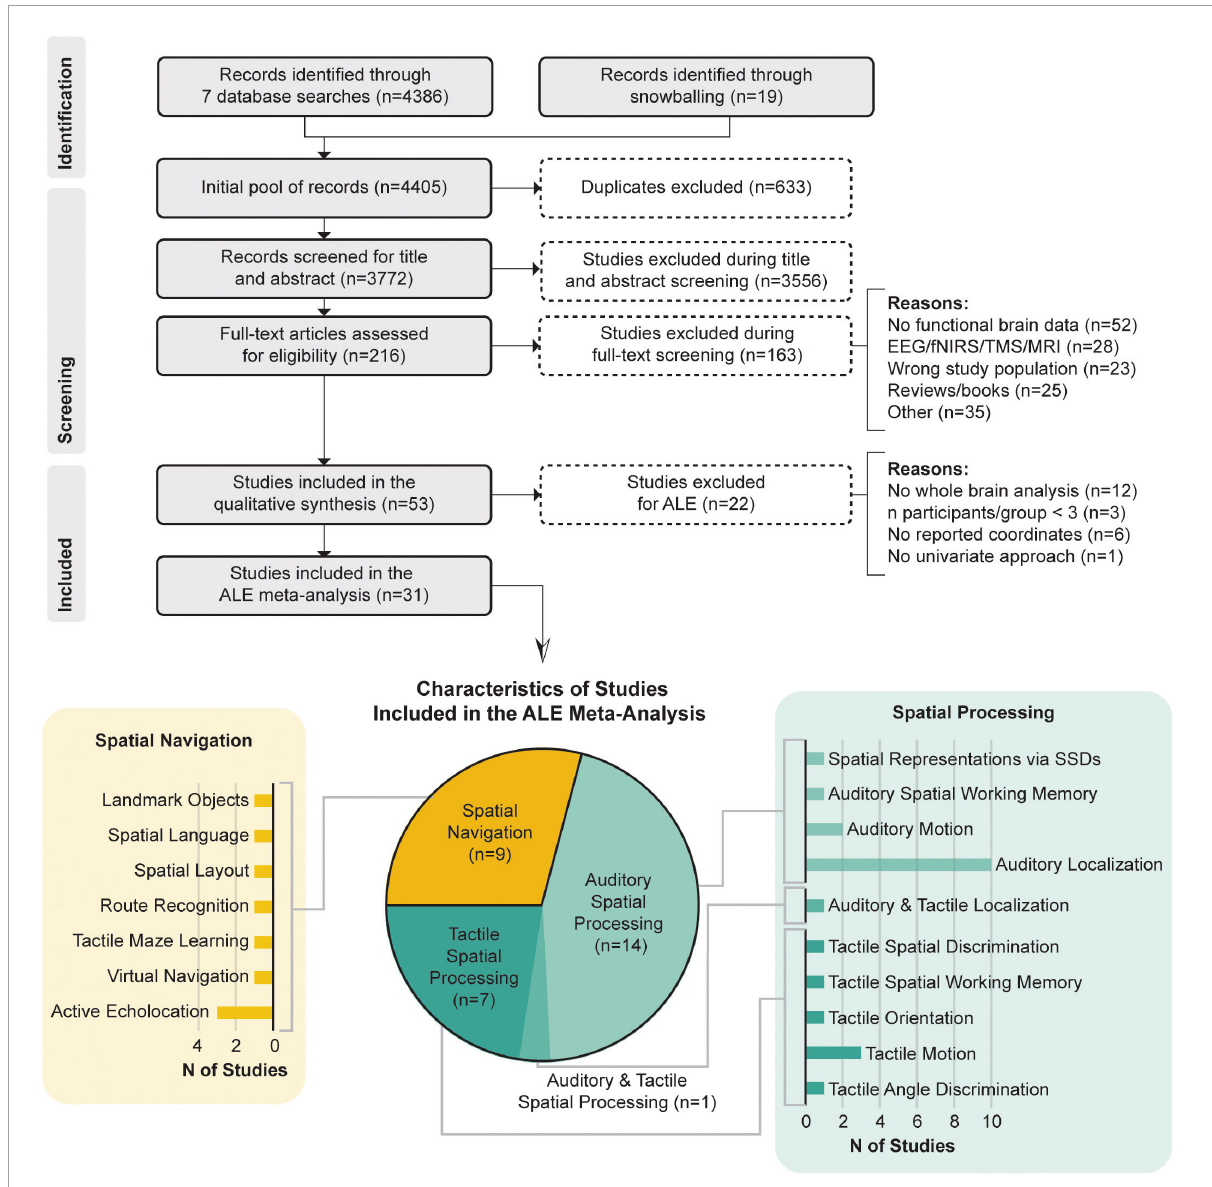
FIGURE1 PRISMA flow chart and characteristics of studies included in the meta-analysis according to datasets and the specific functional domains they